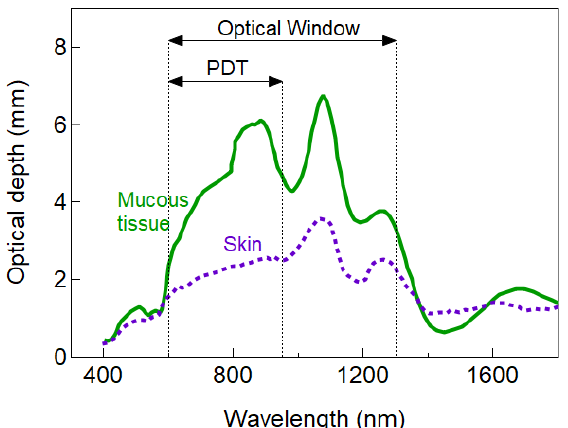
Figure 4. Example of the wavelength dependence of penetration depth for two different tissue types. Data were taken from [76]. The light wavelength has a strong impact on light penetration. For I-PDT, typically red light (around 650 nm) is employed and the expected penetration depth for most tissues is below 1 cm (<4 mm for mucous tissue).